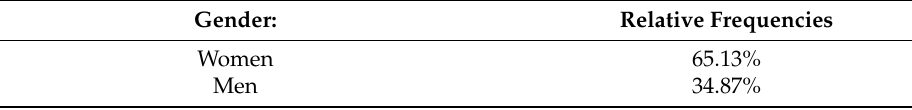
Table 2. Contingency table–Education. Education: Relative Frequencies Primary 7.27% Secondary 70.15% Tertiary